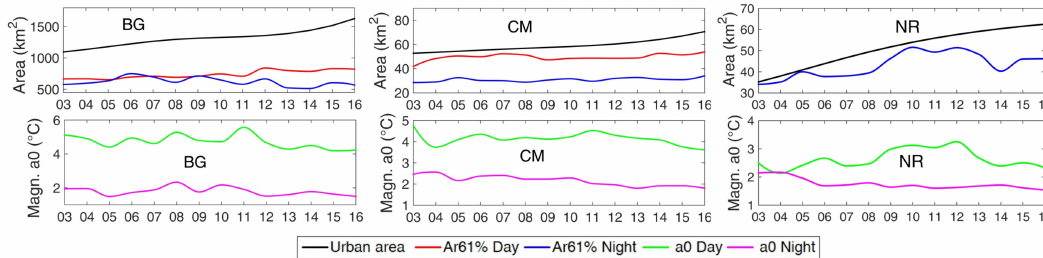
Figure 11. BG, CM, and NR: yearly trend (2003–2016) of the urban area computed from land use and land cover (LULC) Landsat maps (black line, upper panel), daytime Ar61% (red line, upper panel), nighttime Ar61% (blue line, upper panel), daytime a0 (green line, lower panel), and nighttime a0 (magenta line, lower panel). For NR, daytime a0 is the maximum SUHI value, since daytime Gaussian fitting is not